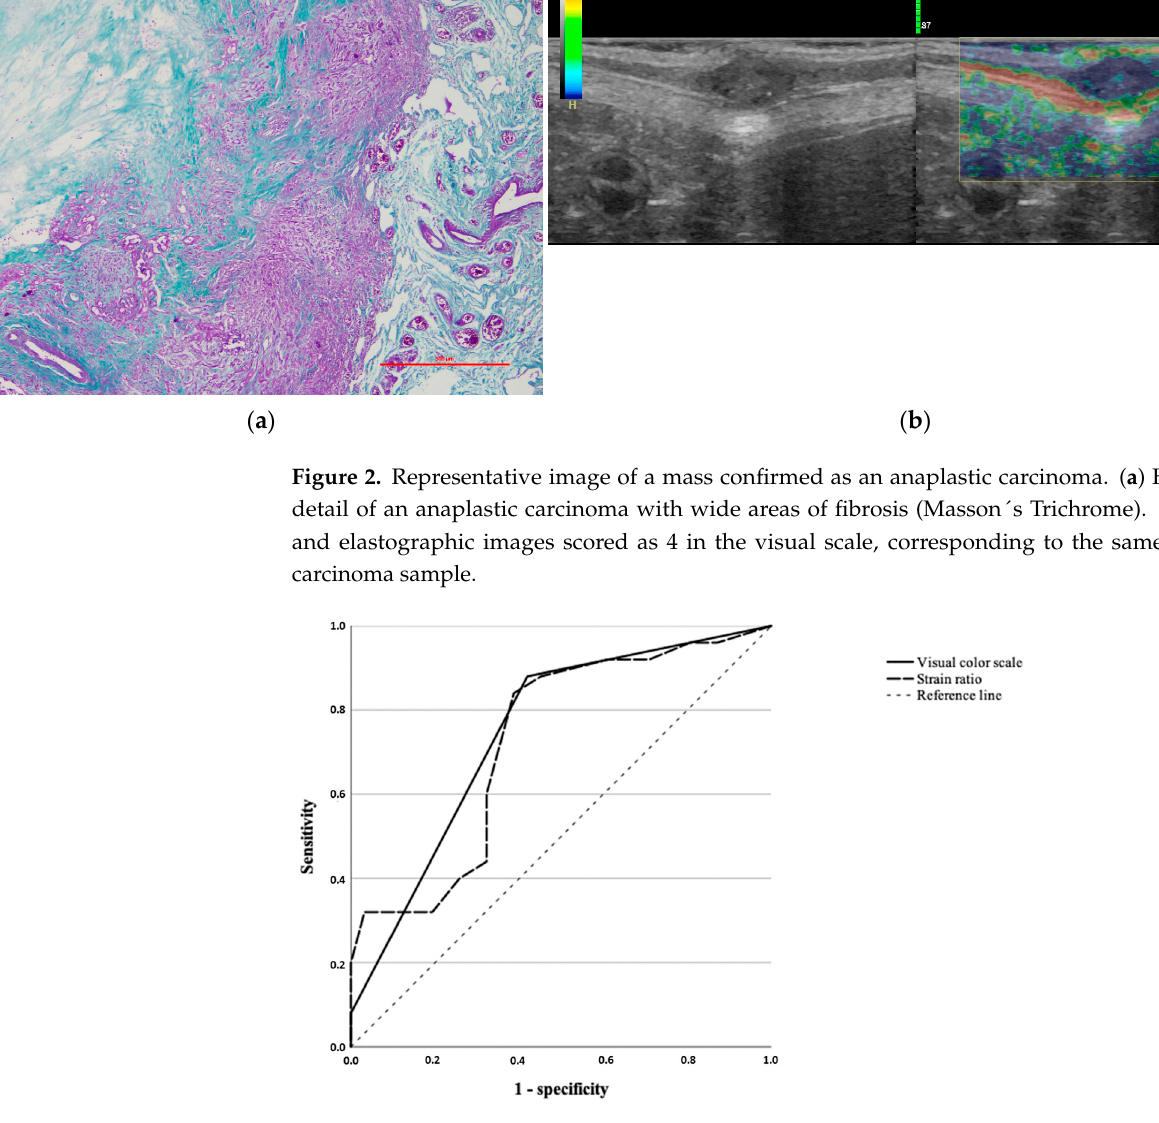
Figure 3. Receiver-operating characteristic curve for the visual color scale (qualitative analysis) ( p = 0.002) and for the strain ratio (semiquantitative analysis) ( p = 0.004).